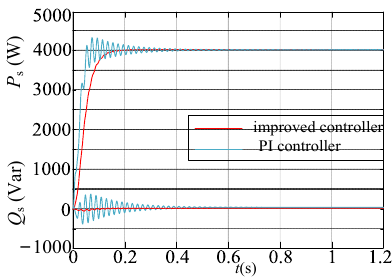
Figure 9. DFIG output power using different controllers.